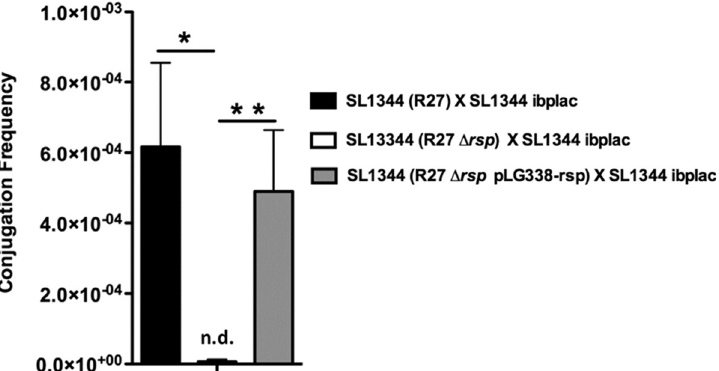
Fig 3. The RSP protein is required for conjugation of the R27 plasmid. Transfer frequencies of the R27 and R27 Δ rsp plasmids. The recipient strain was the SL1344 ibplac strain. The donor strains were SL1344 (R27), SL1344